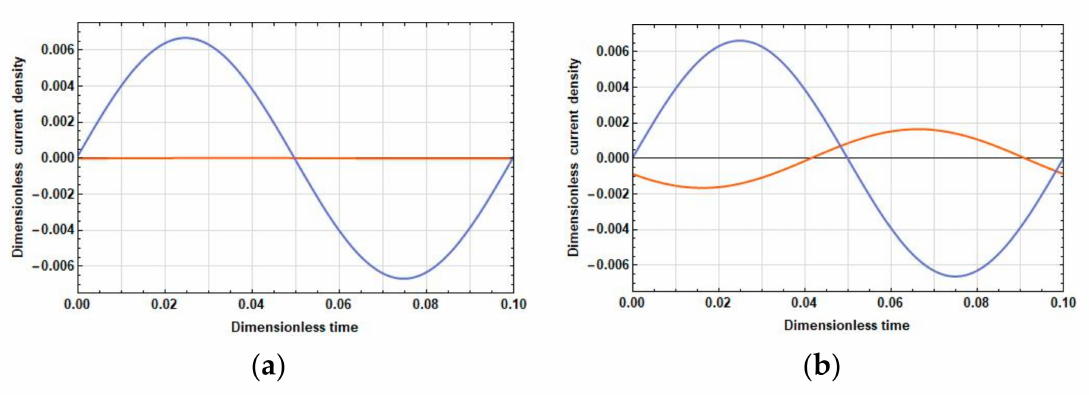
Figure 5. A change in time of a linear density current at the edges of the cathodes during the period of an external signal with the frequency ˜ f = 10 at: ( a ) 2˜ l c = 0; and ( b ) 2˜ l c = 1. ˜ B 1,1 (orange lines) is the cathode edge from the side of the other cathode and ˜ B 1,25 (blue lines) is the cathode edge from the side of the adjacent